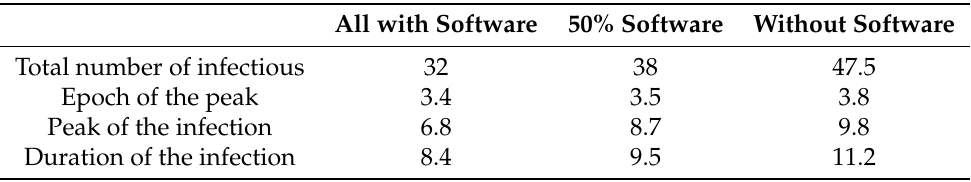
Table 14. Effect of the efficient security